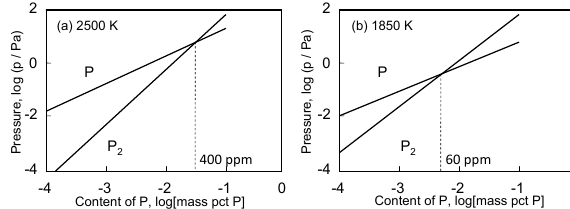
Figure 9. Calculated pressure of P and P 2 at (a) 2500 K (b) 1850